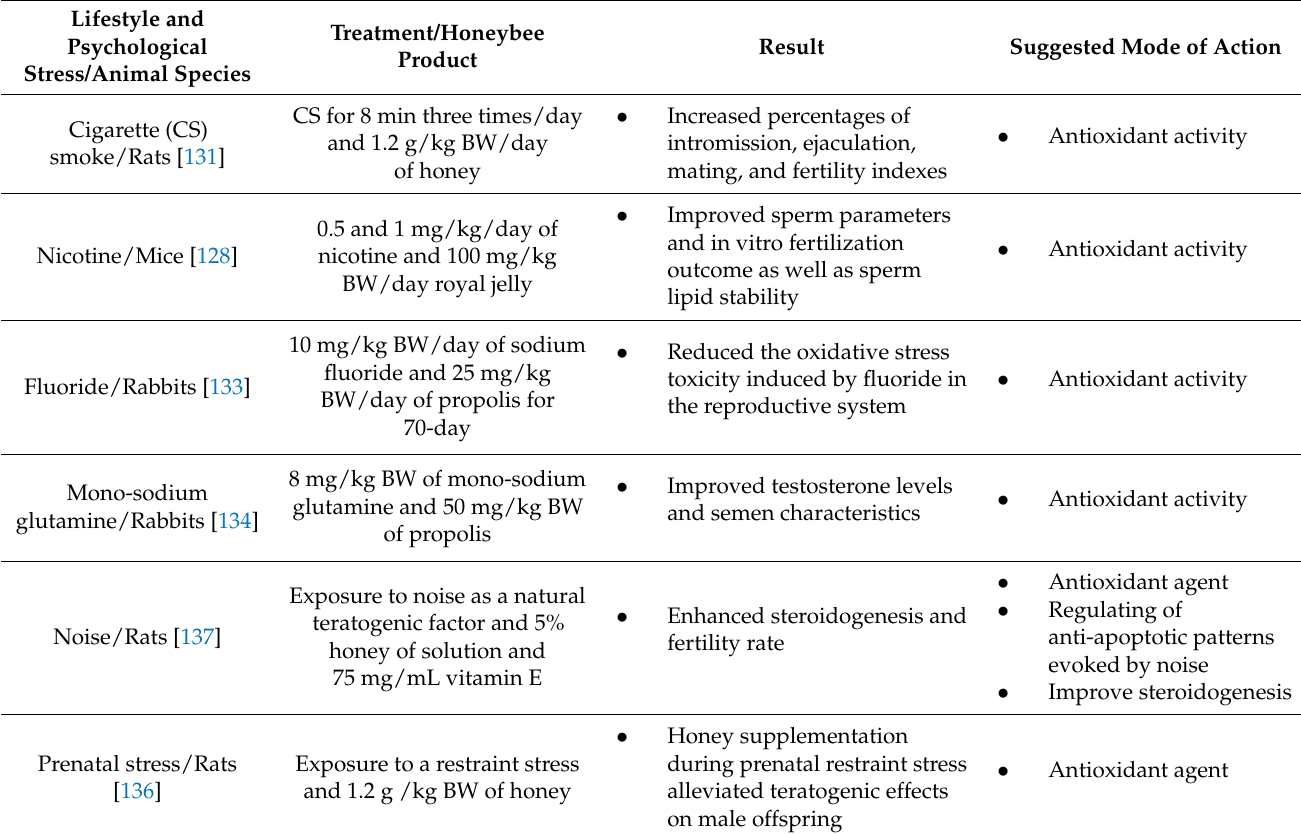
Table 8. Impact of honeybee products on animal reproductive disorders induced by unhealthy lifestyle and psychological